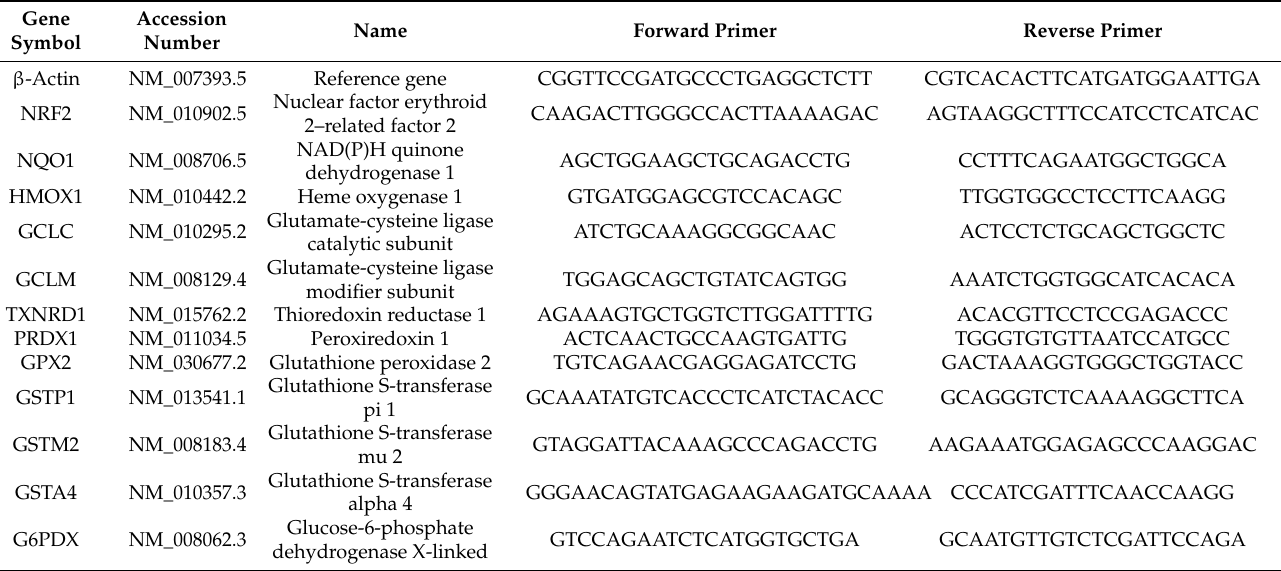
Table 1. The genes and primers for qPCR